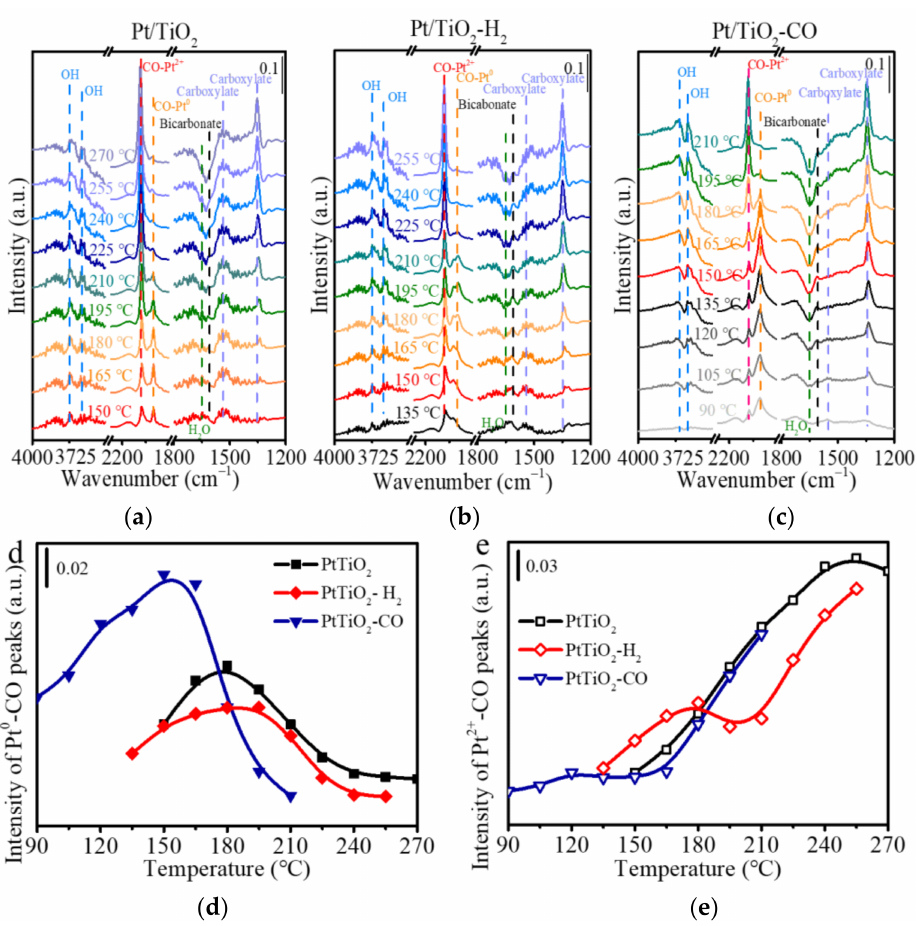
Figure 7. In situ DRIFT spectra in the CO oxidation for ( a ) Pt/TiO 2 , ( b ) Pt/TiO 2 -H 2 , and ( c ) Pt/TiO 2 - CO catalysts; and IR intensity of ( d ) Pt 0 -CO and ( e ) Pt 2+ -CO as a function of temperatures. Figure 7d,e summarizes the IR intensity of Pt 0 -CO and Pt 2+ -CO as a function of reaction temperature. The Pt 0 -CO peak intensity of Pt/TiO 2 , Pt/TiO 2 -H 2 , and Pt/TiO 2 - CO reaches their summit at 180 ◦ C, 180 ◦ C, and 150 ◦ C, respectively, which correspond with their activity tests in Figure 4a (i.e., the T 100 of 210 ◦ C, 190 ◦ C, 150 ◦ C, respectively). The Pt 0 -CO peak intensity of Pt/TiO 2 -CO at low temperature is higher than those of the Pt/TiO 2 -H 2 and Pt/TiO 2 -CO, indicating that Pt/TiO 2 -CO owns high CO adsorption capacity. The Pt 2+ -CO accumulates up to a temperature of 255 ◦ C in Figure 7e, which is much higher than Pt 0 -CO, implying that CO is adsorbed more strongly on Pt 2+ than Pt 0 -CO [35,36] upon exposure to the reactant gases. These results are consistent with the literature [35,43] that linear CO adsorbed on metallic Pt is responsible for reacting in the low-temperature CO oxidation, while the CO adsorbed on ionic Pt participates in the CO oxidation along with the increasing temperature. The abundant metallic Pt sites introduced by the reduction pretreatment, especially the CO pretreatment, are responsible for the high activity in the low-temperature CO